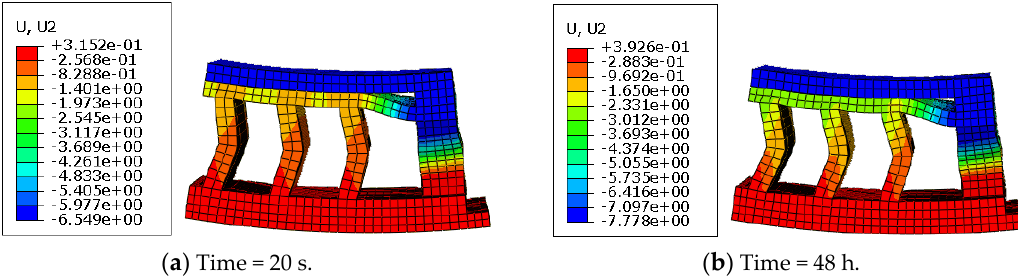
Figure 19. Creep profiles of the rubber system at different times ( T = 23 °C; F = 2.0 kN).